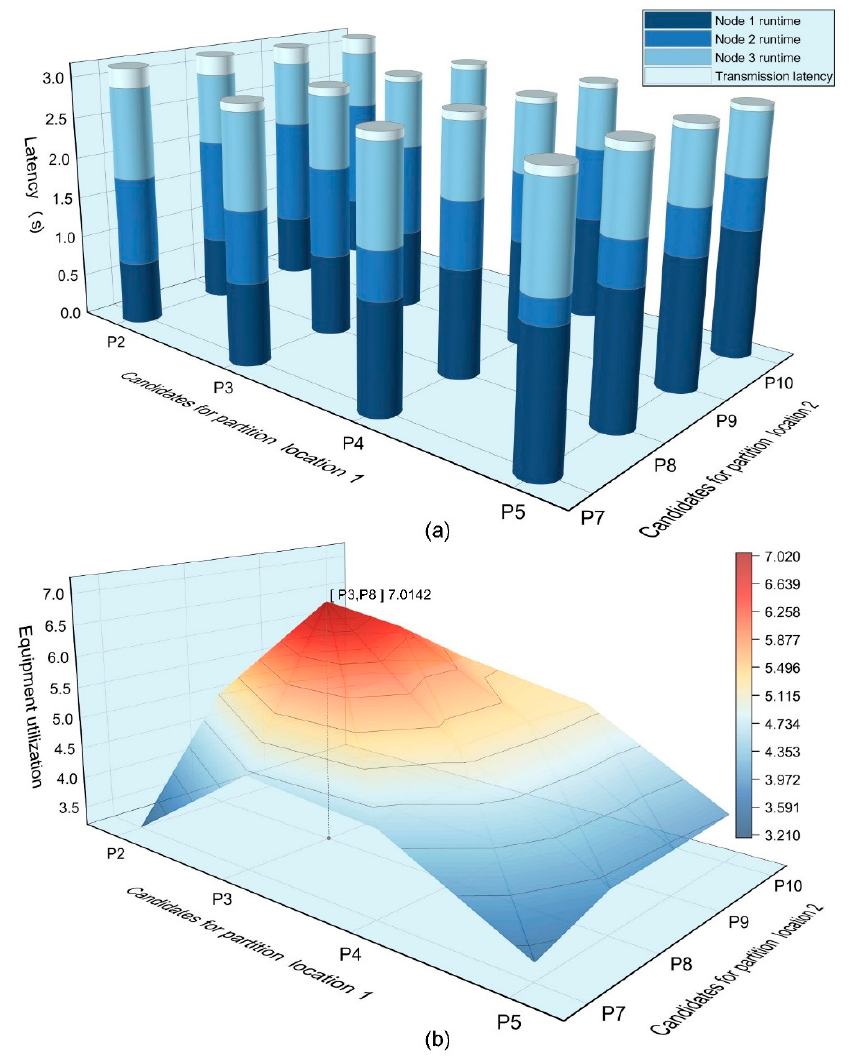
Figure 14. CWB calculates the optimal partition points. Two sets of candidate partition points are (cid:4668)𝑝 (cid:4669) and (cid:4668)𝑝 (cid:4669) , the rest of the partition points have been screened out as (cid:2870) , 𝑝 (cid:2871) , 𝑝 (cid:2872) , 𝑝 (cid:2873) (cid:2875) , 𝑝 (cid:2876) , 𝑝 (cid:2877) ,𝑝 (cid:2869)(cid:2868)